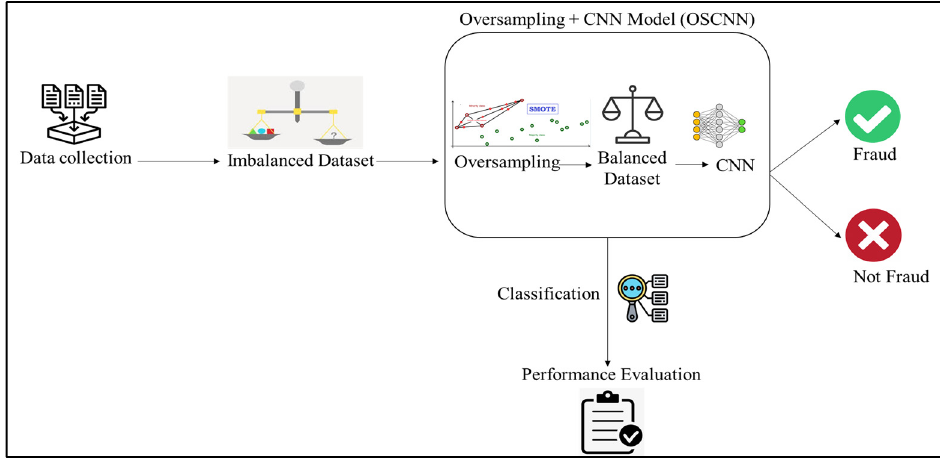
Figure 6. Over Sampling Convolution Neural Network Model (OSCNN).